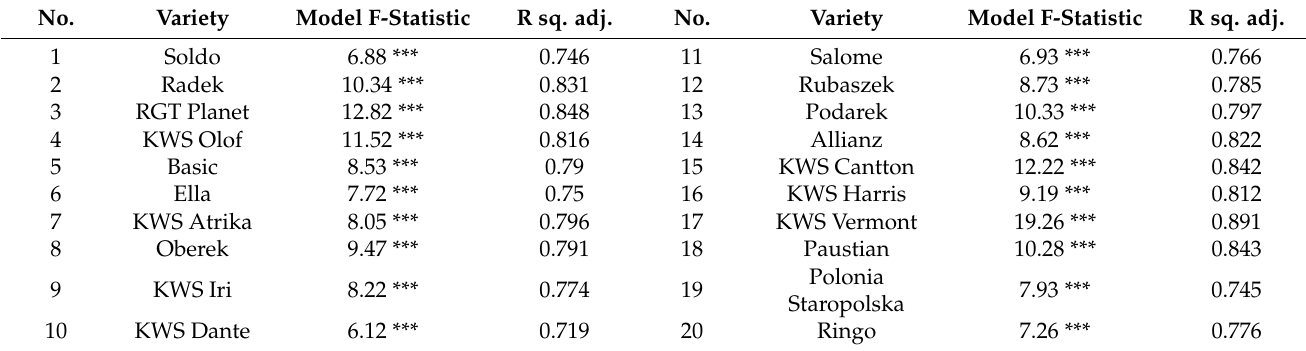
Table 4. R-squared AGRO-SBY yield prediction models developed using MLR method for twenty varieties based on the data collected in thirteen locations including genetic potential, environment, and management traits under moderate input management system.